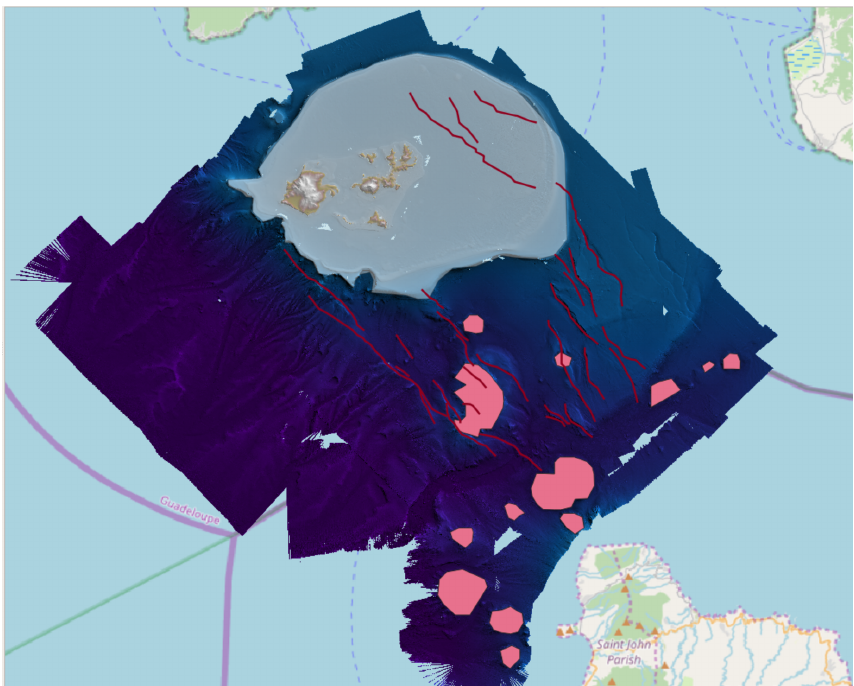
Figure 2. Snapshot of the QGIS desktop showing an example of expected first-order interpretation of the 10m DEM using QGIS drawing tools. The Les Saintes reef plateau is contoured in transparent white, submarine volcanoes are shown in pink, and active fault scarps are shown in red. Erosional features like canyons could also be mapped since they are often detected by students and may be misidentified as tectonic